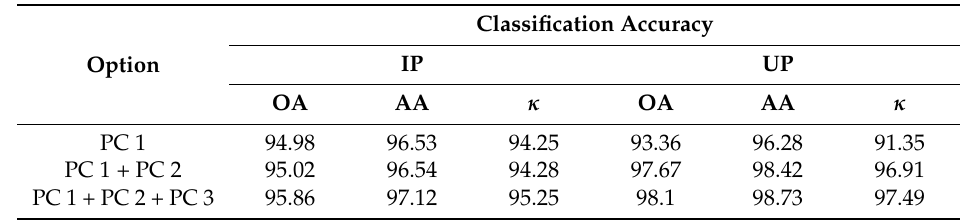
Table 7. Classification accuracy (%) by the SVM-SSHK method under different number of PCs for the IP and UP images.